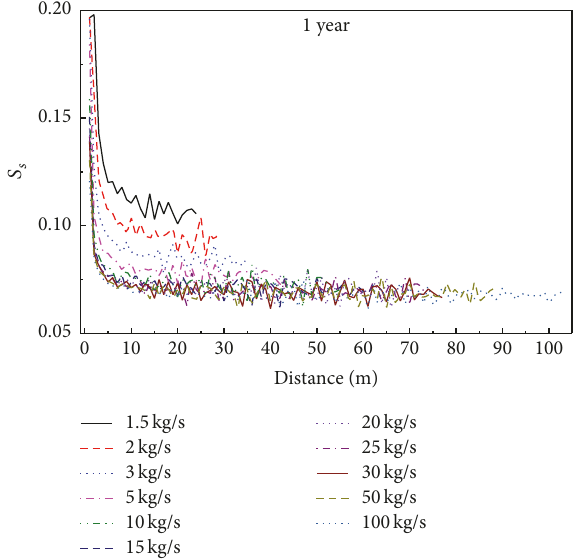
Figure 16: Relationships between the different 𝑄 near the injection